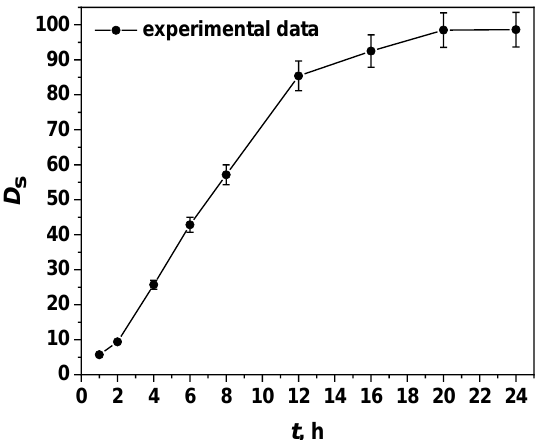
Figure 6. Effect of contact time on the degree of sorption D s of Cr(III) onto Cr(III)-IIM at initial concentration 5 mg/L, pH 6, temperature 40 °C, and adsorbent dose (one membrane) 0.140 g.